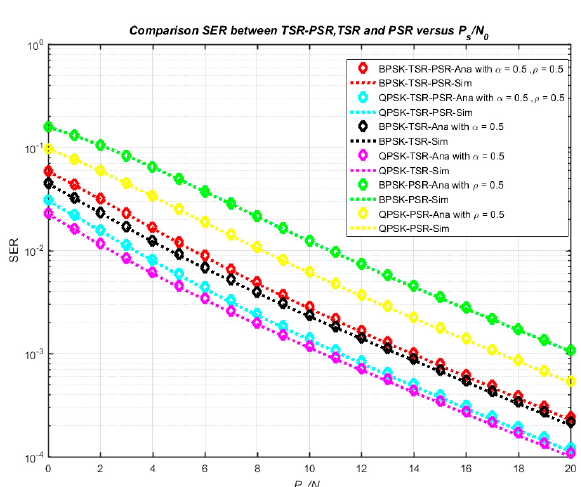
Figure 7. Outage probability versus ρ and α .